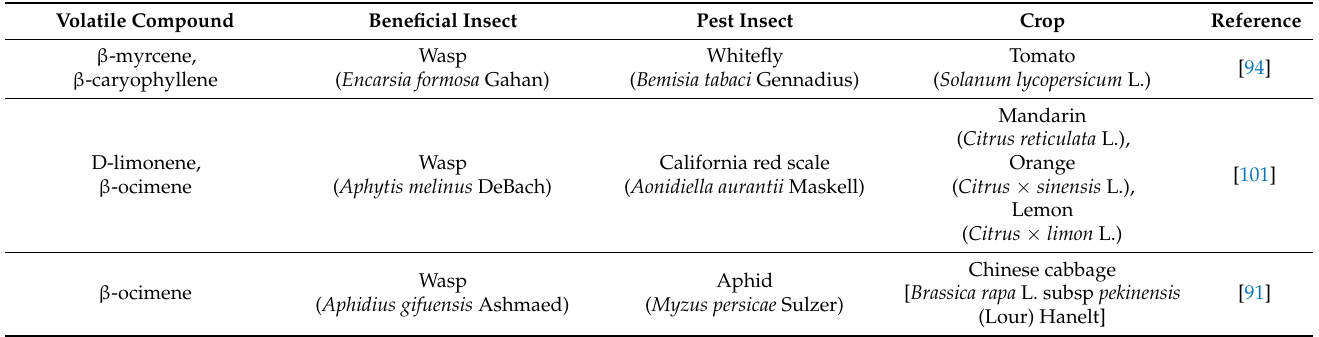
Table 2. Herbivore-induced plant volatiles with attraction capacity of natural